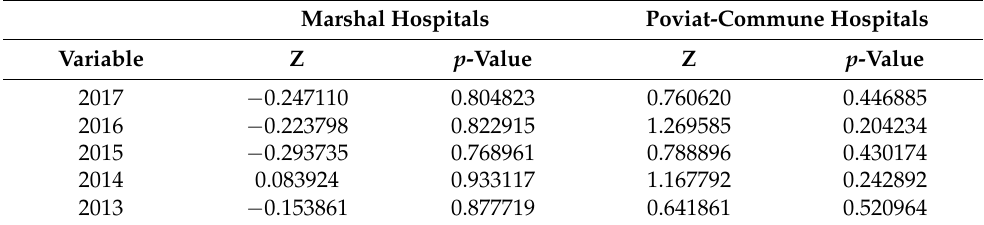
Table 6. Results of the Mann–Whitney U test for SLV for Marshal